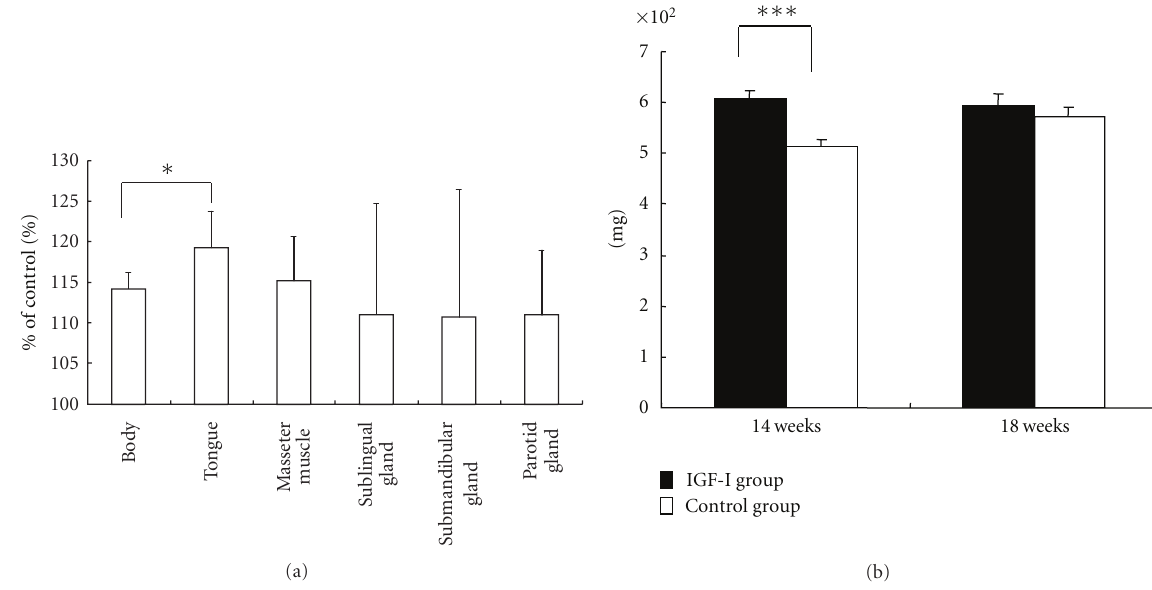
Figure 2: (a) Changes in body weight and soft oral tissue weight at 14 weeks of age in the IGF-I group compared to control ( ∗ P < 0 . 05 versus total body weight). (b) Tongue weight at 14 and 18 weeks of age in IGF-I-treated and control rats ( ∗∗∗ P < 0 . 001 versus control). Data represent the mean ± SD of six rats, adapted from a previous report